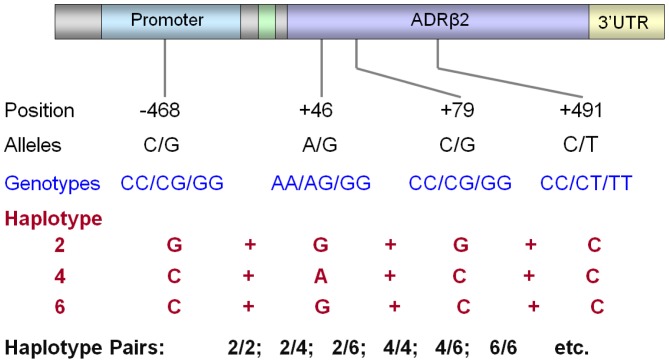
Schematic representation of ADRβ2 genotype, haplotype and haplotype pair.